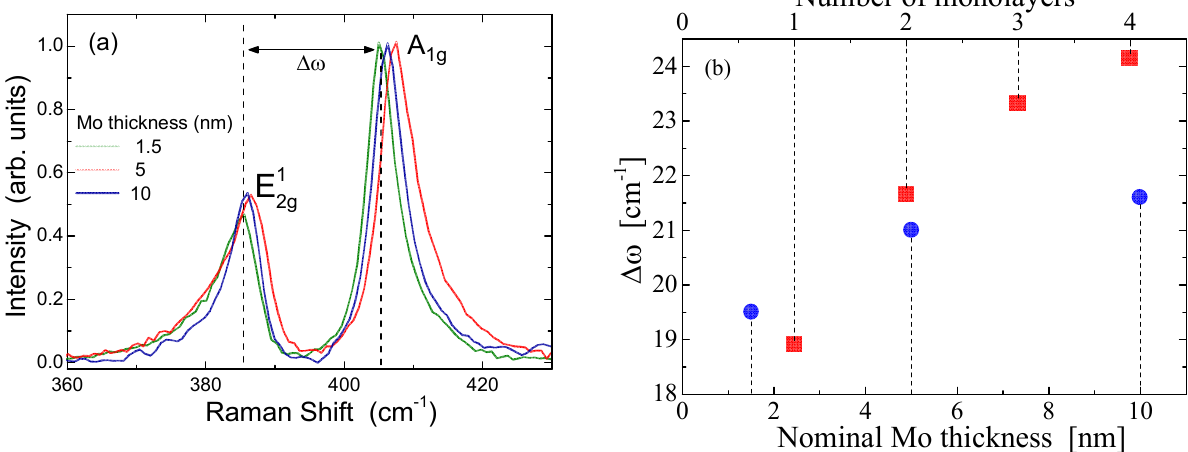
Figure 5. ( a ) Raman spectra of ZnO/MoS 2 heterostructures. ( b ) The dependence of ∆ ω vs. the nominal Mo thickness (solid spheres). The solid squares denote the dependence of ∆ ω against the number of MoS 2 monolayers taken from Ref. [18].